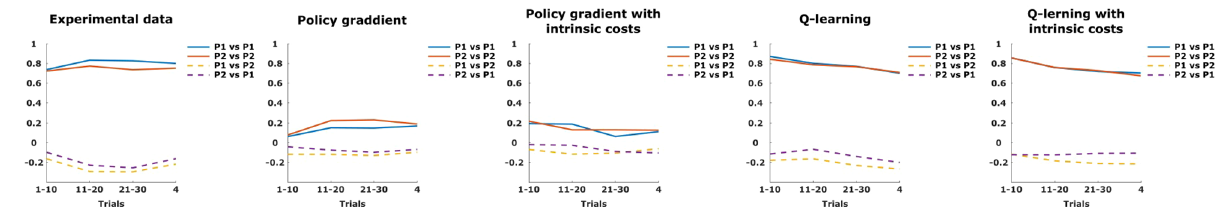
Figure 6. Autocorrelation in the symmetric matching pennies. The solid lines show the autocorrelation between actions from the current and the previous trial for both players. The dashed lines indicate cross- correlations between one players action in the current trial with another player’s action in the previous trial. From left to right: experimental data, policy gradient, policy gradient with intrinsic costs, Q-learning, Q-learning with intrinsic costs. Created using MATLAB R2021a (https:// www. mathw orks. com) 43